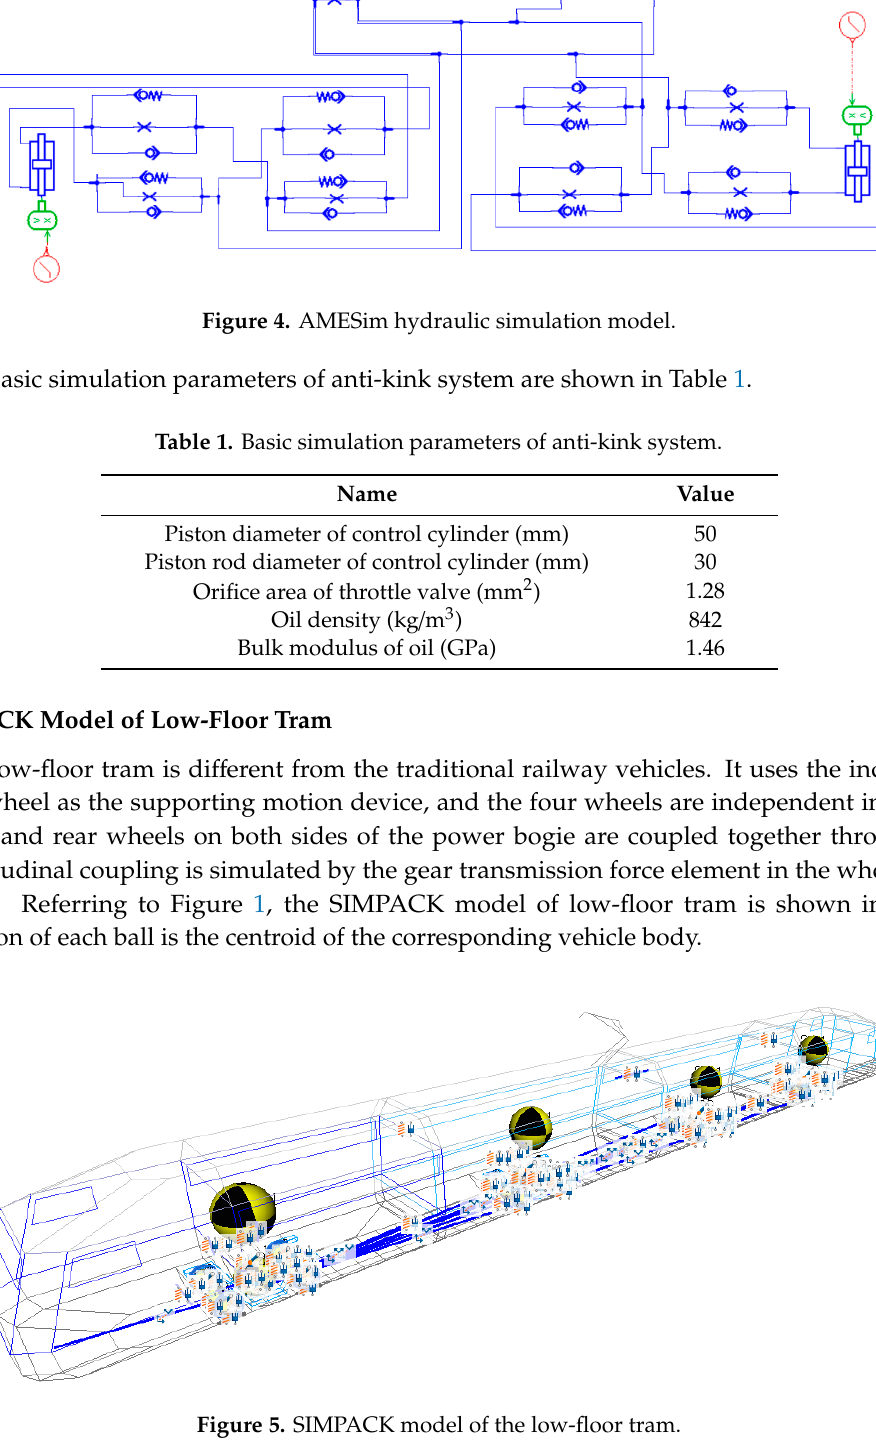
Table 2. Basic simulation parameters of the low-floor tram.